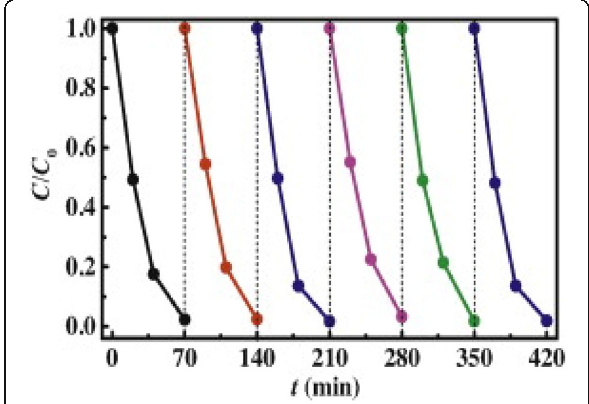
Fig. 11 Cycling runs for photocatalytic degradation of RhB over g- C 3 N 4 /Bi 2 MoO 6 composite A8 under visible light irradiation. Reproduced with permission [23]. Copyright 2014 Elsevier